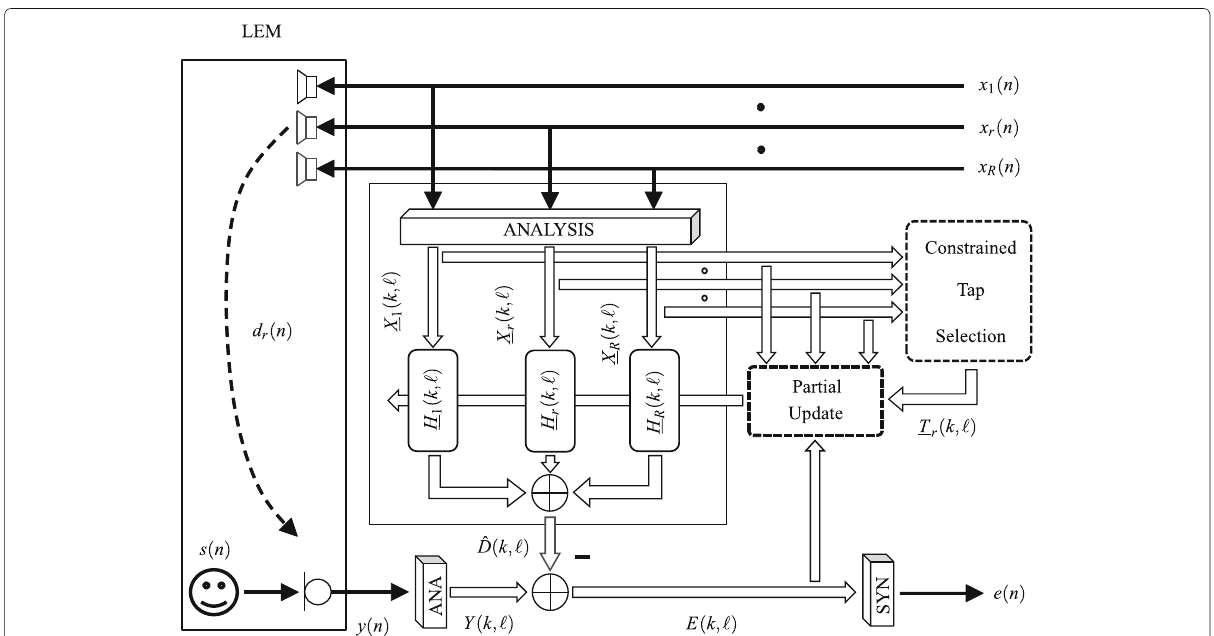
Fig. 1 Block diagram of the considered subband MAEC setup. Thin black arrows are used for signals processed in the time-domain, while solid white arrows are used for signals processed in the subband domain